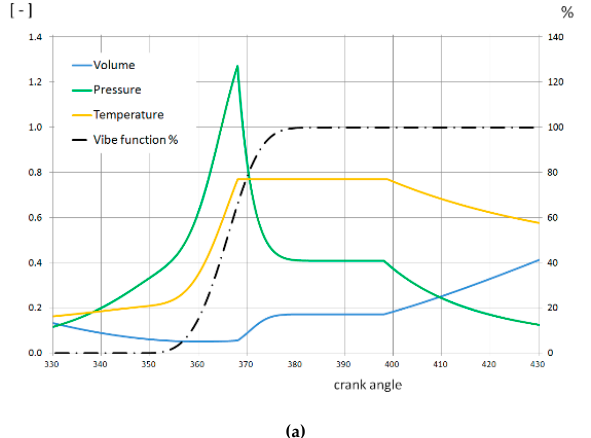
Figure 8. Comparison of volume changes in the complementary system, calculated analytically with those determined by five terms of the Fourier series for 1500 rpm, cr = 14:1.